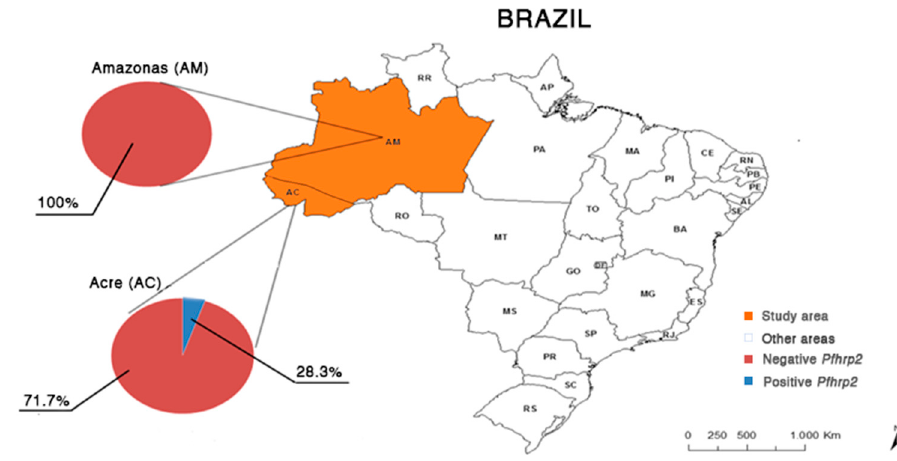
Figure 2. Map of the geographical distribution of the frequency of pfhrp2 -positive and negative P. falciparum isolates observed in the states of Acre ( n = 99) and Amazonas ( n = 60), Brazilian Amazon region. Data: continuous cartographic base of Brazil of 2015; Brazilian Institute of Geography and Statistics (IBGE) .